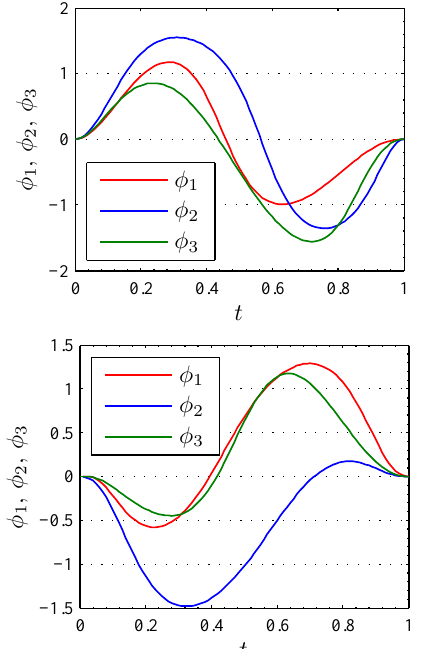
Figure 6. Joint angles: egalitarian solution (top) and prioritarian solution (bottom).